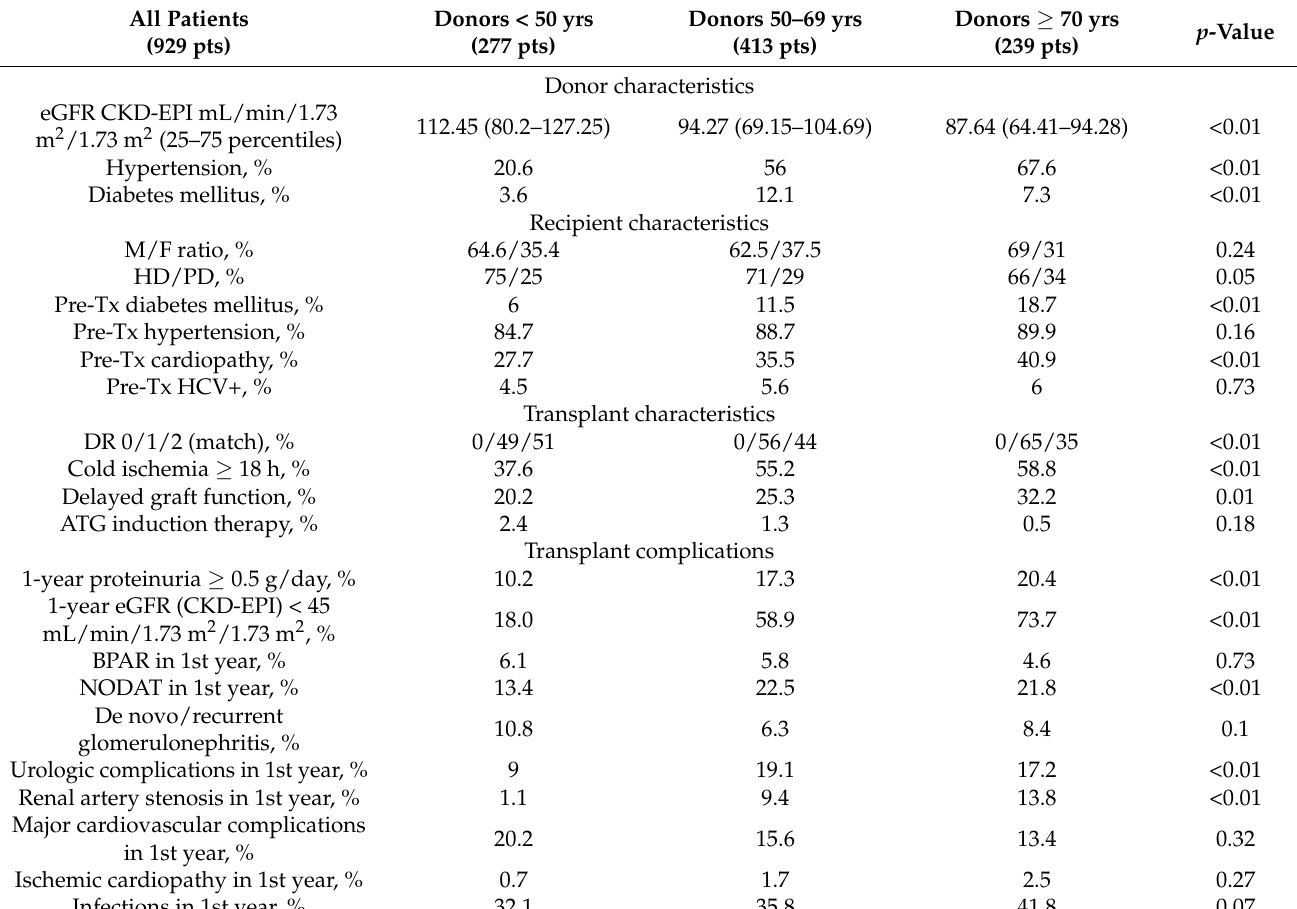
Table 3. Main characteristics of patients with different donor ages.